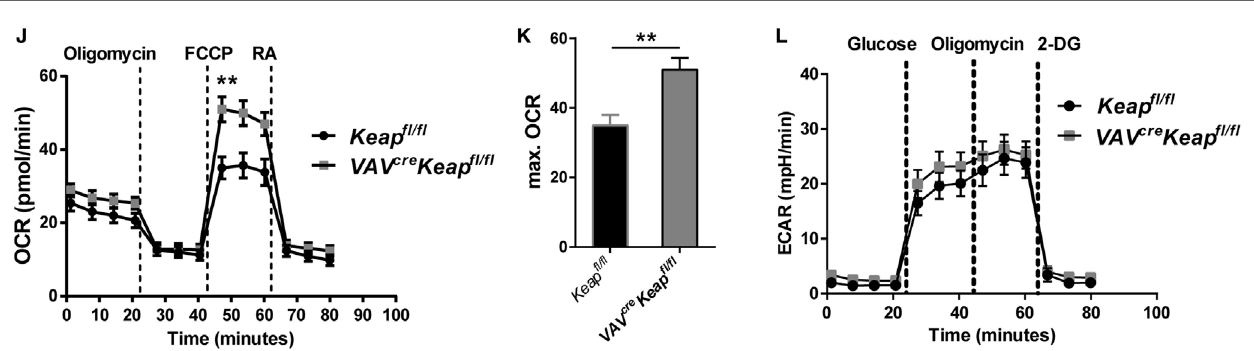
FigUre 5 | Nrf2 induces metabolic activity in myeloid-derived suppressor cells (MDSCs). (a) Metabolic enzymes regulated by Nrf2 in glucose metabolism in MDSCs (own microarray and RT-qPCR data). (B) N-fold mRNA expression of metabolic enzymes in MACS isolated Keap fl/fl and VAV cre Keap fl/fl CD11b + Gr-1 + ( n = 7–8, PFKFB3 n = 5) cells analyzed by RT-qPCR. Bars indicate mean and error bars SEM, two-tailed one sample test. (c) 2NBD-glucose incorporation was analyzed in CD11b + Gr1 + splenocytes from Keap fl/fl ( n = 3) and VAV cre Keap fl/fl ( n = 4) mice at different time-points, two-tailed unpaired t -test. (D) BM-derived cells were incubated with GM-CSF and IL-6 for 8 days with different glucose concentrations, and frequencies of CD11b + Gr-1 + cells were assessed by flow cytometry. Bars indicate mean ± SEM of three independent experiments per group, two-tailed unpaired t -test. (e,F) BM-derived cells were incubated with GM-CSF and IL-6 for 8 days in the absence or presence of 1 µM rapamycin, n = 4, two-tailed unpaired t -test. (g) Representative histogram of five experiments ( p = 0.0155, two-tailed paired t -test) showing p-mTOR expression in splenic CD11b + Gr-1 + cells. (h) Mean fluorescent intensity of pS6 expression in CD11b + Gr-1 + cells. (i) Statistical analysis of mitochondrial mass of Keap fl/fl ( n = 4) and VAV cre Keap fl/fl ( n = 4) CD11b + Gr-1 + cells evaluated by assessing NAO mean fluorescence intensity, n = 3, two-tailed unpaired t -test. (J) OCR measured under basal conditions and after addition of the indicated drugs. Points indicate mean from six Keap fl/fl ( n = 6) and six VAV cre Keap fl/fl ( n = 6) CD11b + Gr-1 + cells, error bars SEM. (K) Statistical analysis of max. OCR. Bars indicate mean ± SEM. (l) ECAR measured under basal conditions and after addition of the indicated drugs. Points indicate mean from six Keap fl/fl ( n = 6) and six VAV cre Keap fl/fl ( n = 6) CD11b + Gr-1 + cells, error bars SEM, two-tailed unpaired t